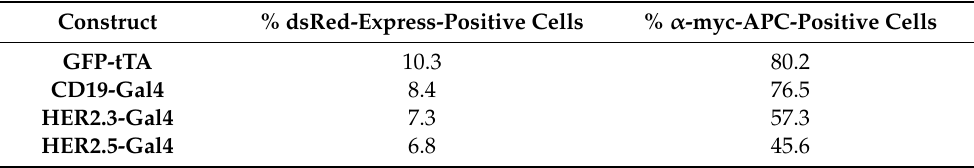
Table 2. Quantification of activation of synNotch receptor systems in bulk populations and clonal cell lines after 60 min of antigen contact and a ratio of one sender cell to one receiver cell.